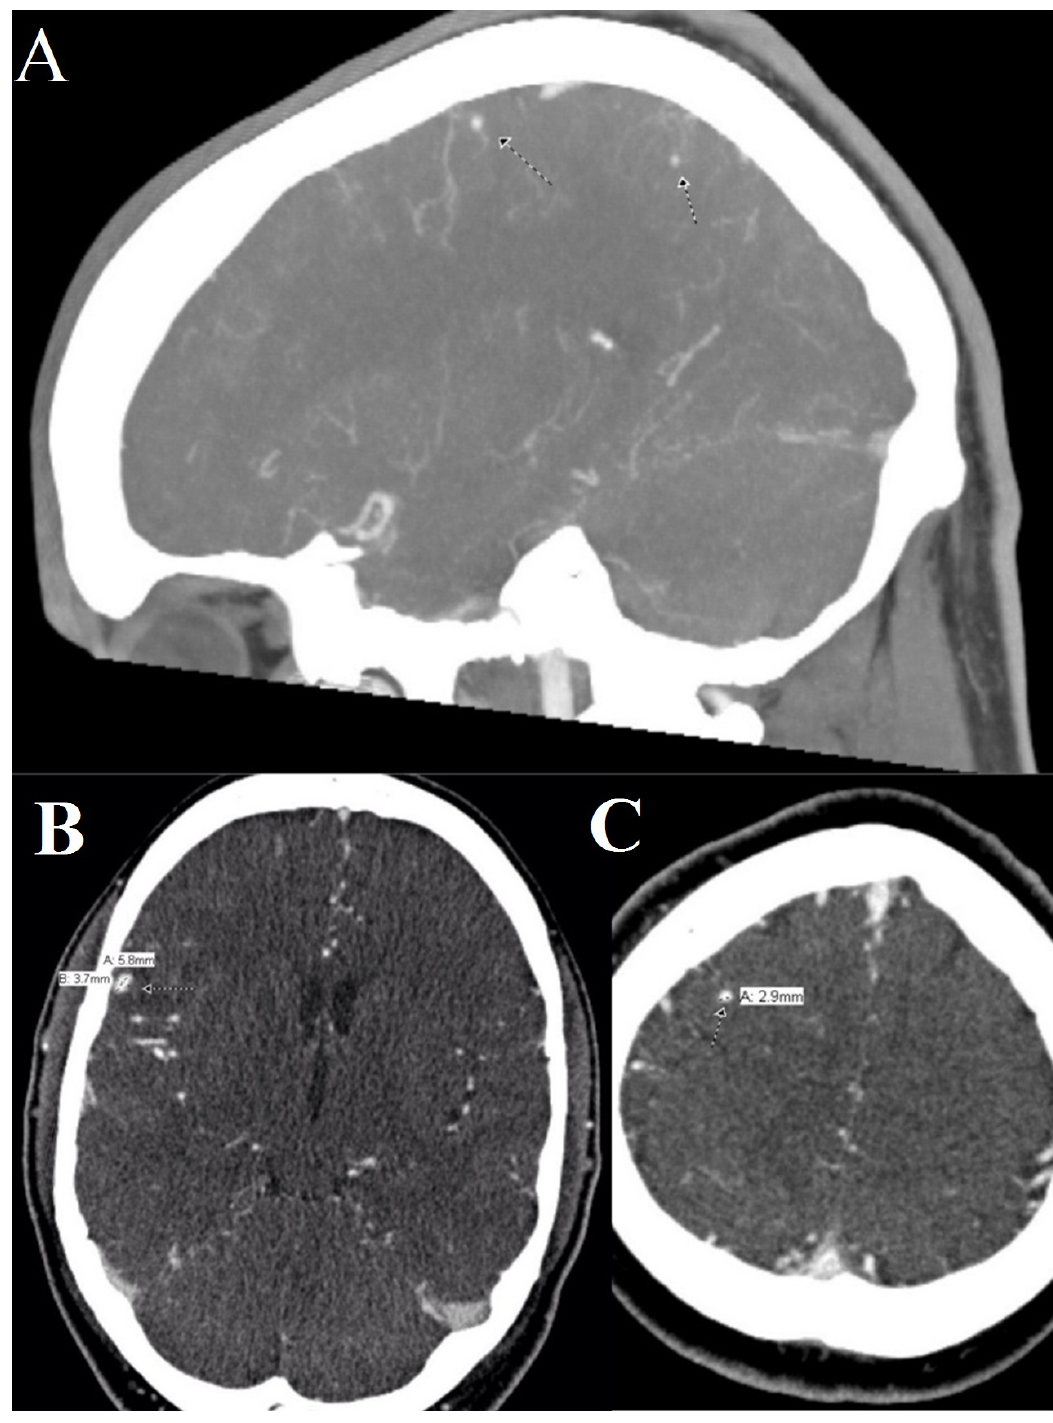
Figure 2. A composite image of the patient’s mycotic aneurysms found on computed tomography angiogram. ( A ) A sagittal view of multiple mycotic aneurysms in the right middle cerebral artery distribution; ( B ) A coronal cross section of a 6 mm by 4 mm mycotic aneuryms in the right middle cerebral artery distribution; ( C ) A coronal cross section of a 2.9 mm mycotic aneurysm in the right middle cerebral artery distribution.